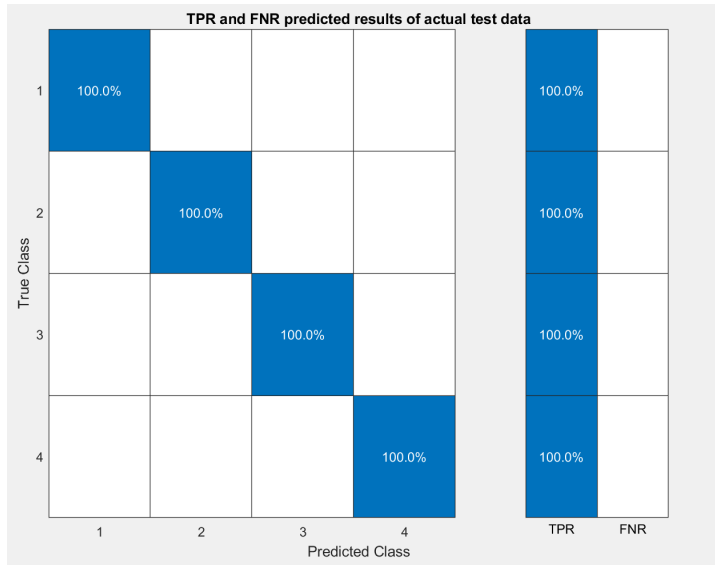
Figure 10. Confusion matrix diagram of actual test data.